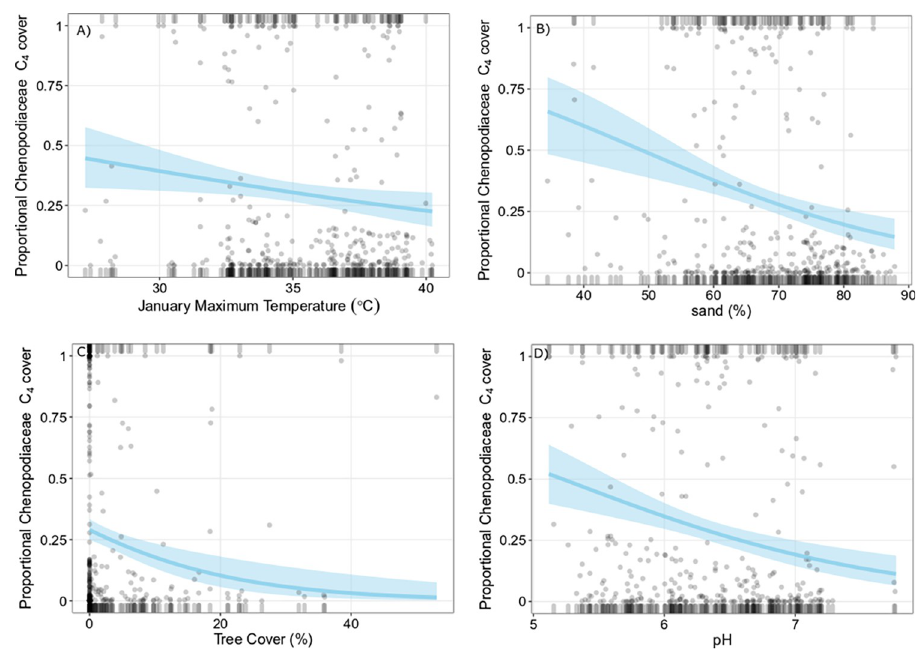
Fig 7. Binomial logistic regressions of proportional C 4 Chenopodiaceae cover. Grey points are partial residuals, blue lines and shaded bands are predicted outcomes of the regression and 95% confidence intervals respectively, and rugs were drawn to indicate observations with positive residuals (top of the plot) or negative residuals (bottom of the plot). For each plot (A-D), independent variables not depicted on the x-axis were held constant at their median value.